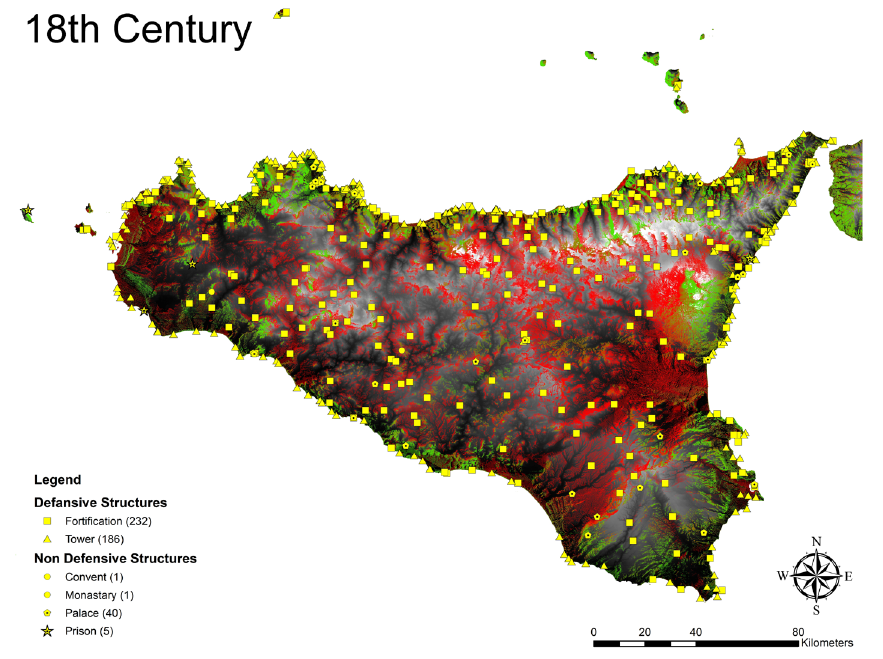
Figure 9. Figure showing the distribution of defensive structures and their viewsheds in the 18th century. Fortifications are represented by squares and the area they have surveillance over is in red whereas towers are represented by triangles and the area they have surveillance over is in green. Also included are church buildings represented by circles, palaces represented by hexagons, and prisons represented by a star. Image derived from an ASTER GDEM (a product of NASA and